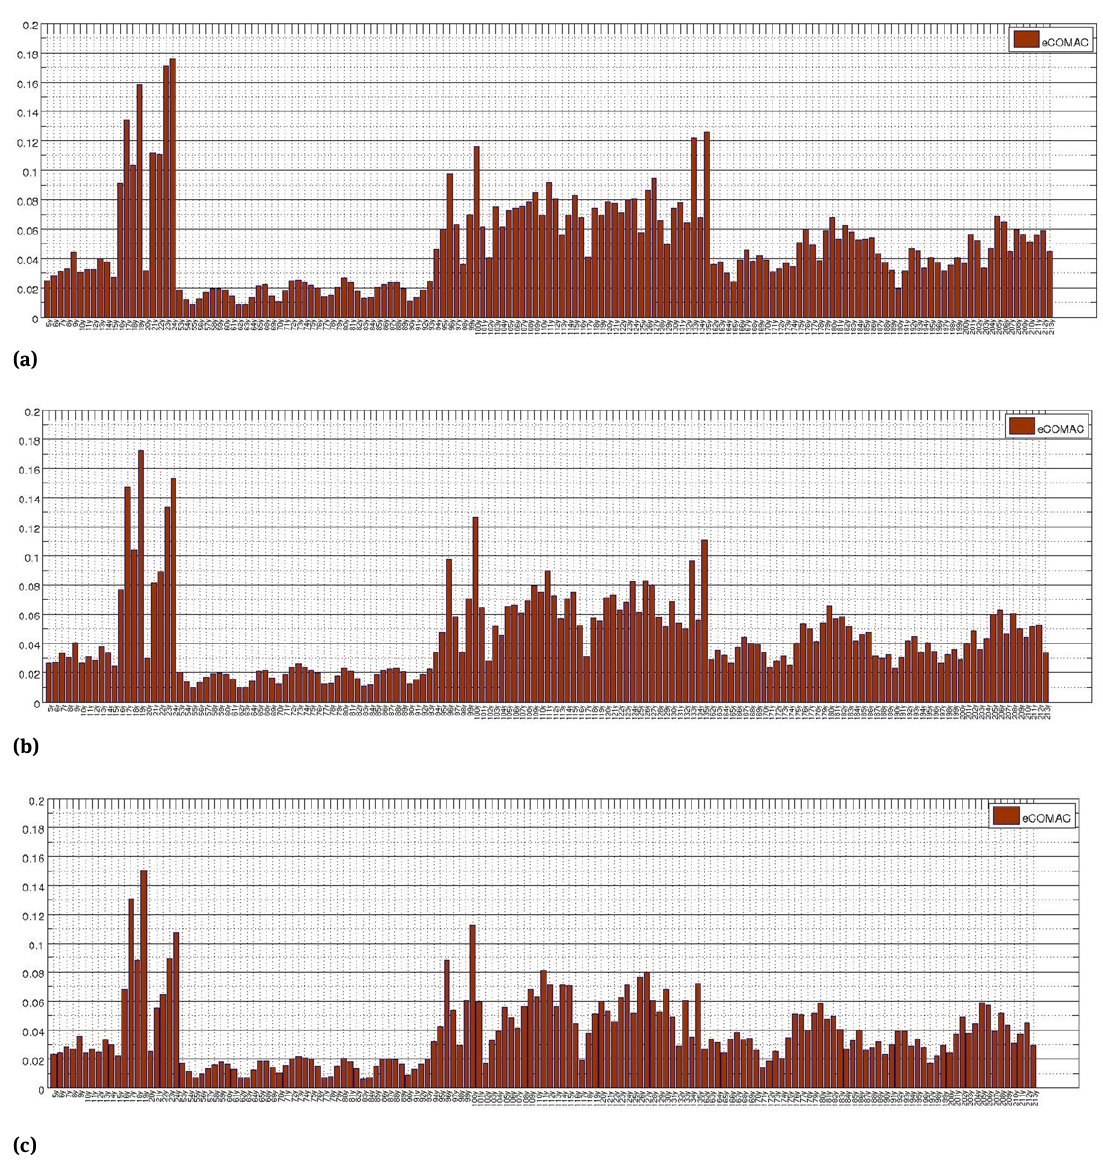
Figure 7: Comparison of eCOMACs: a) SDtools-Exp(updated) b) MSC/NASTRAN-Exp (updated), c)